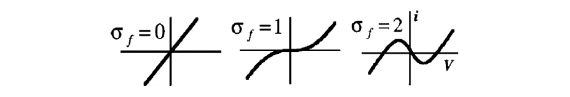
FiguRe 1 | effect of σ parameter on the fast current (extract from Rowat f and Selverston, 1997). A adjusts the width of the N-shape (right) without f affecting the degree of N-shape.